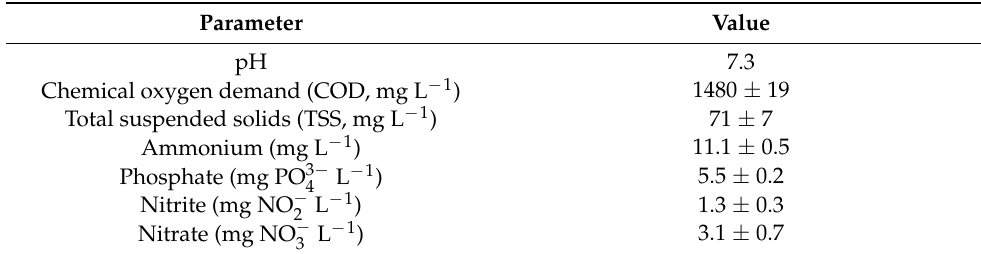
Table 1. Physicochemical characteristics of diluted